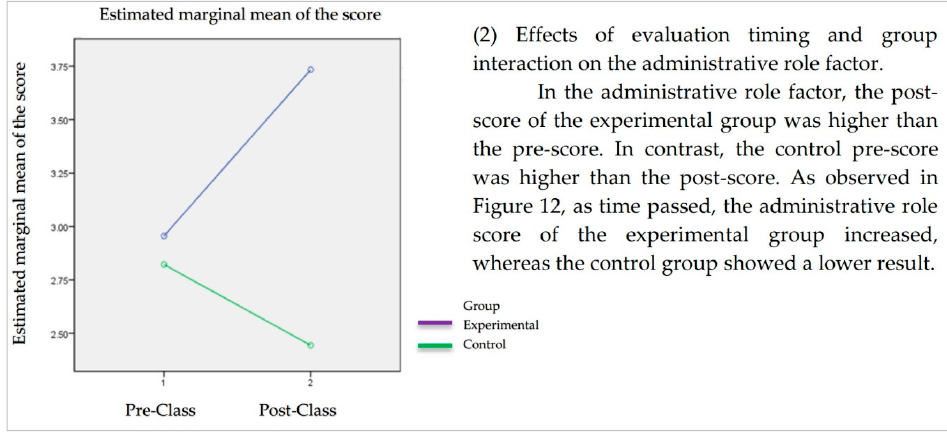
Figure 10. Effect of timing and group interaction on Administrative Role.